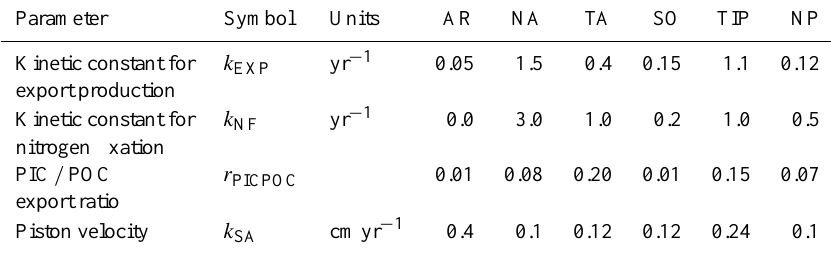
Table A4. Biogeochemical parameter values determined by fitting the model to observations. Parameter Symbol Units AR NA TA SO TIP NP Kinetic constant for k EXP export production Kinetic constant for